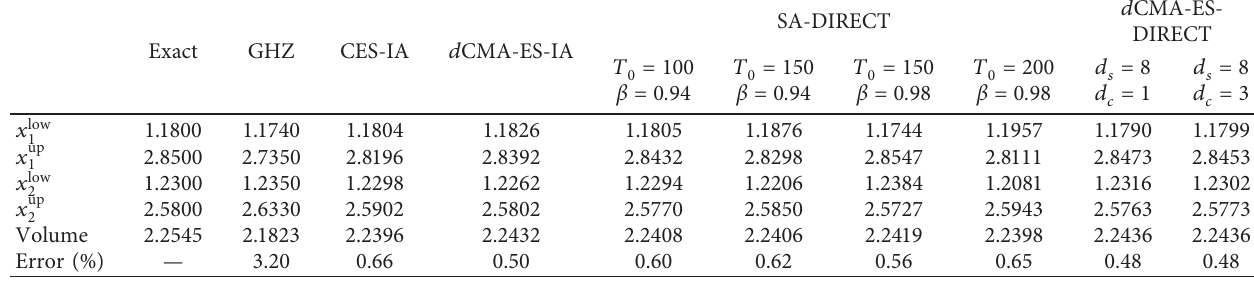
Table 1: .The exact, GHZ, CES-IA, d CMA-ES-IA, SA-DIRECT, and d CMA-ES-DIRECT solutions of Example